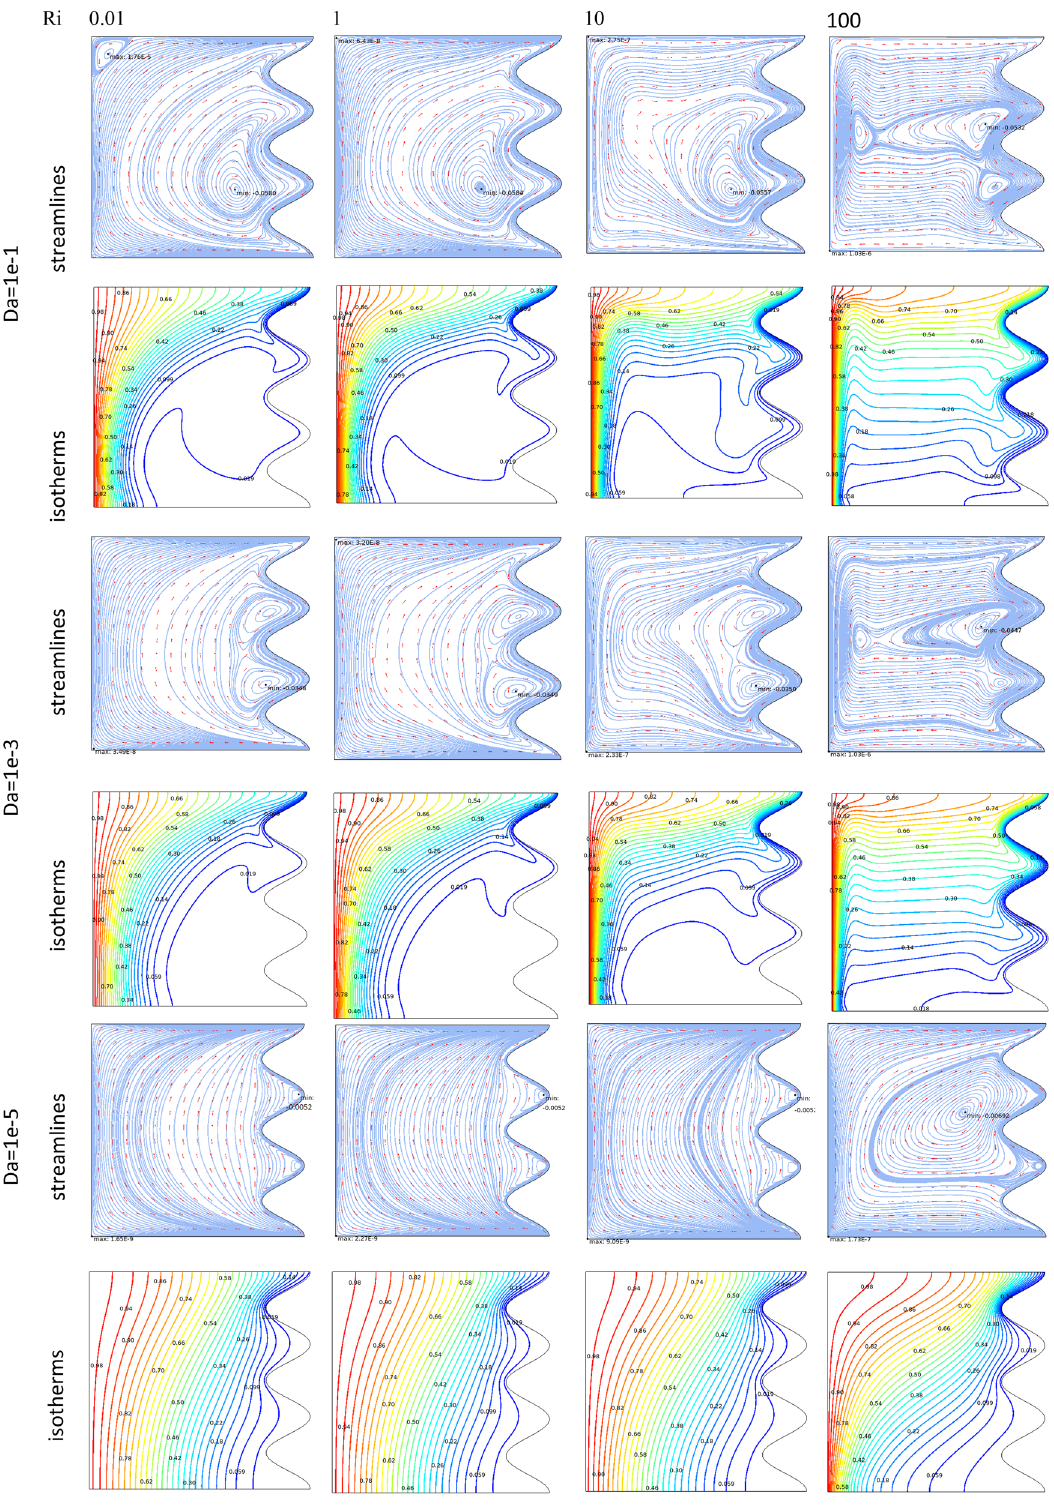
Figure 3. Streamlines and isotherms at (Re = 100, λ = 5, φ = 0.02, Ha = 25, γ = 45, A = 0.1, N = 3) for Case